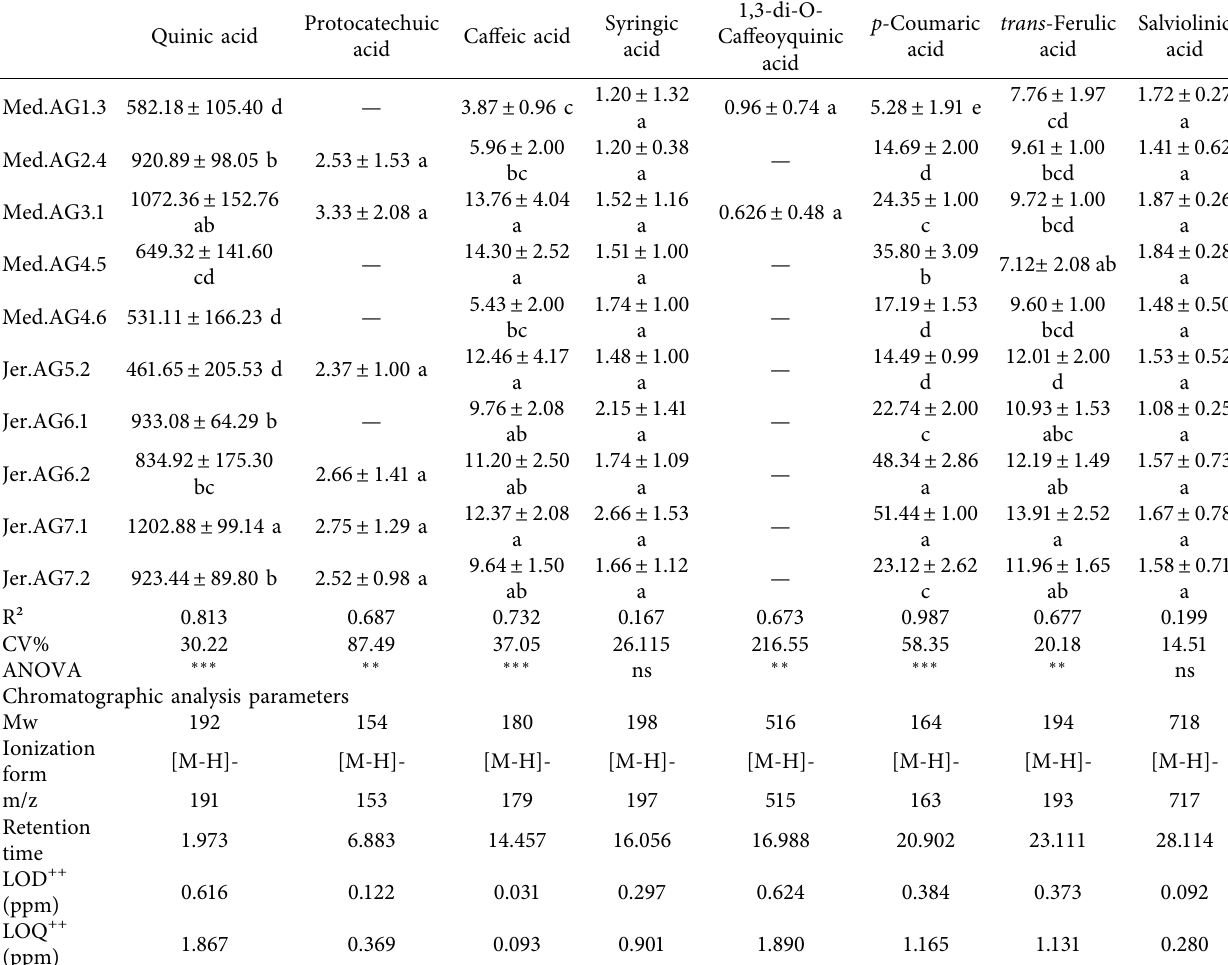
Table 4: Phenolic acid contents ( µ g · g − 1 DM) identified in the methanol extracts of grains of millet